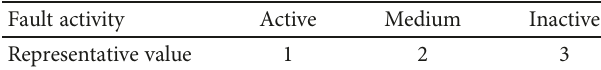
Table 2: Rock mass integrity.